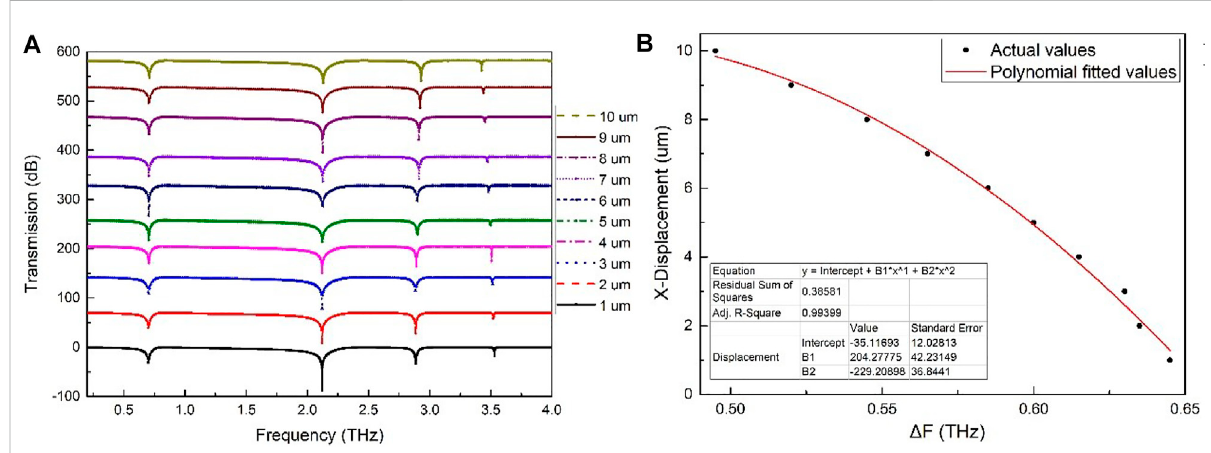
FIGURE 6 The x displacement measurement method for the THz displacement sensor. (A) Transmission spectra of the proposed THz-DS with different x displacements. (B) The relationship diagrams between x displacement and the Δ F.